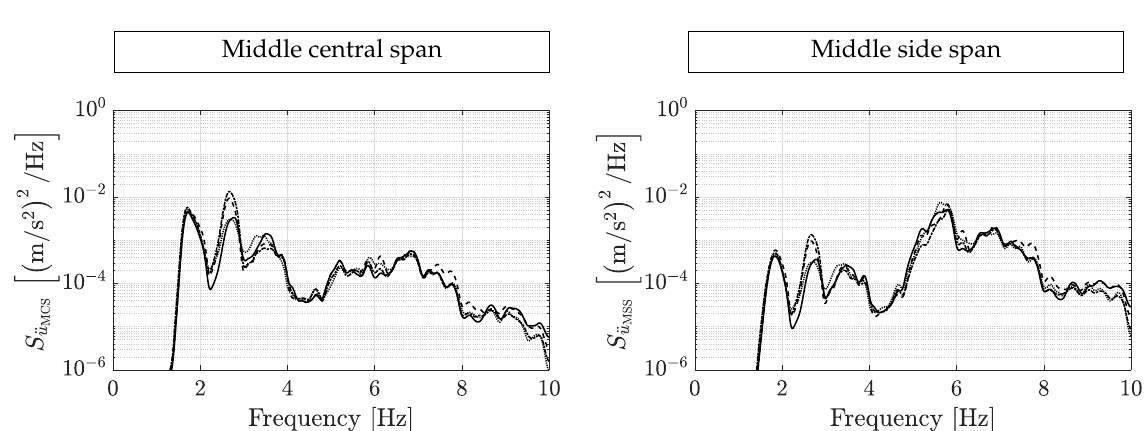
Figure 19. PSD of the vertical structural response at the middle of the central span and middle of the side span: reference response (solid), reconstructed response where the internally-driven contact forces are reconstructed using the total L5 accelerations using RM I (dashed), RM II (dash-dotted), or RM III